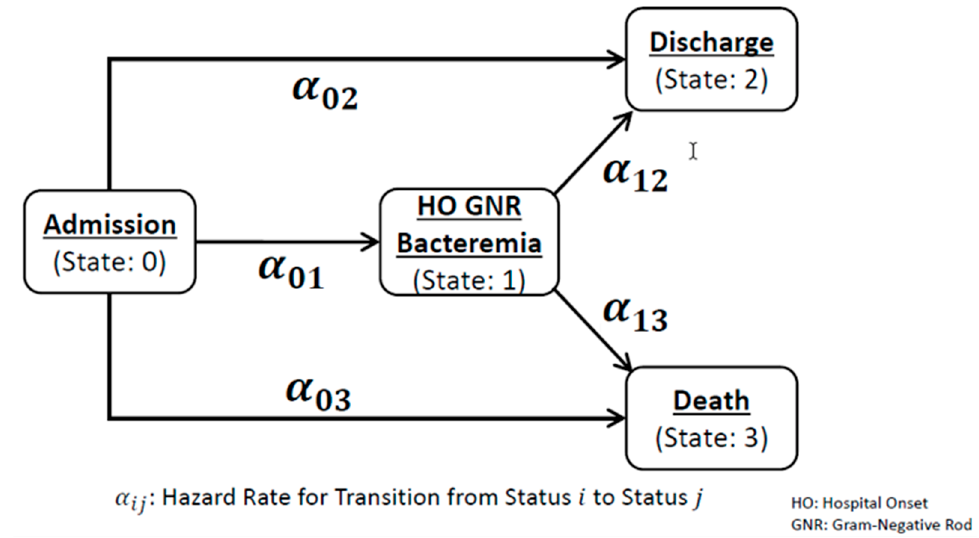
Figure 1. Diagram of the Multistate Model to Estimate Extra Length of Stay.